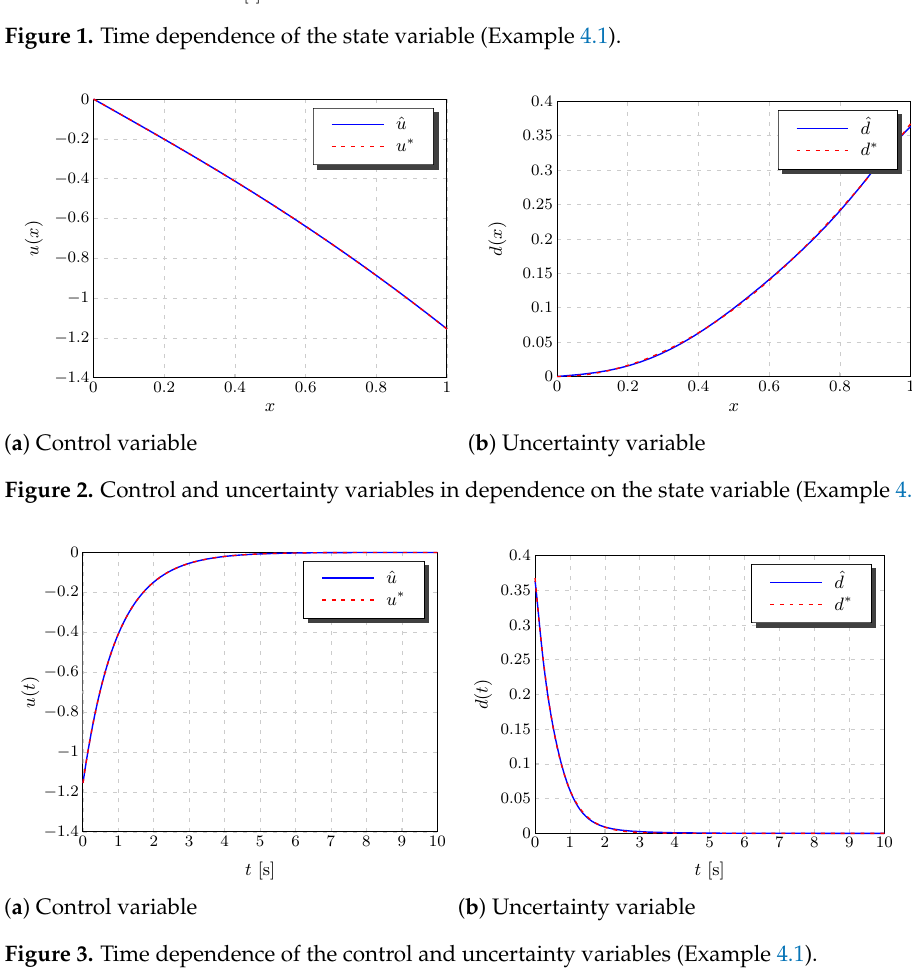
Figure 3. Time dependence of the control and uncertainty variables (Example